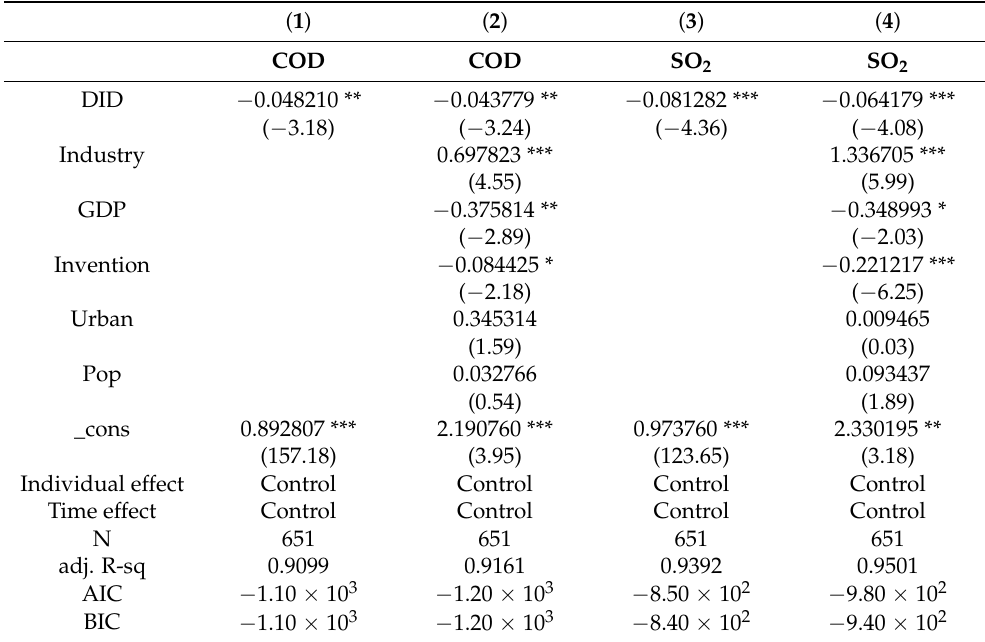
Table 2. Eco-province pilot pollutant emission intensity treatment effects—Time-Varying DID